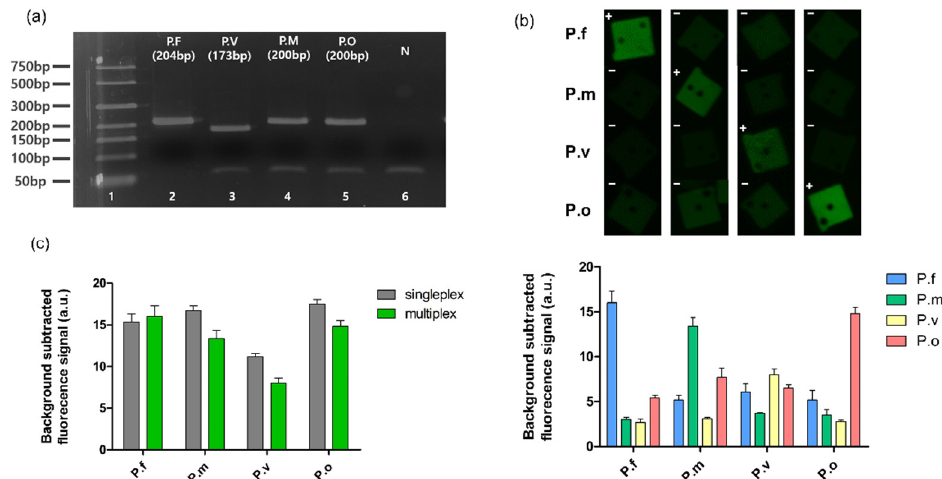
Figure 4. Multiplex BREP assay. ( a ) Validation of amplification using agarose gel electrophoresis (Mul-